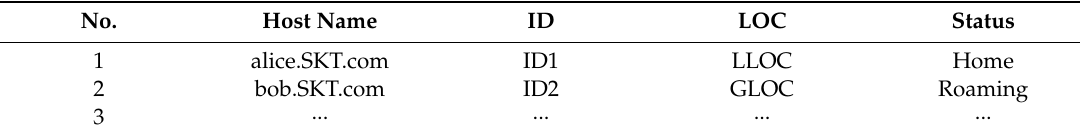
Table 2. Visiting Host Register (VHR) in LGU.com domain. Table 1. Home Host Register (HHR) in SKT.com domain.